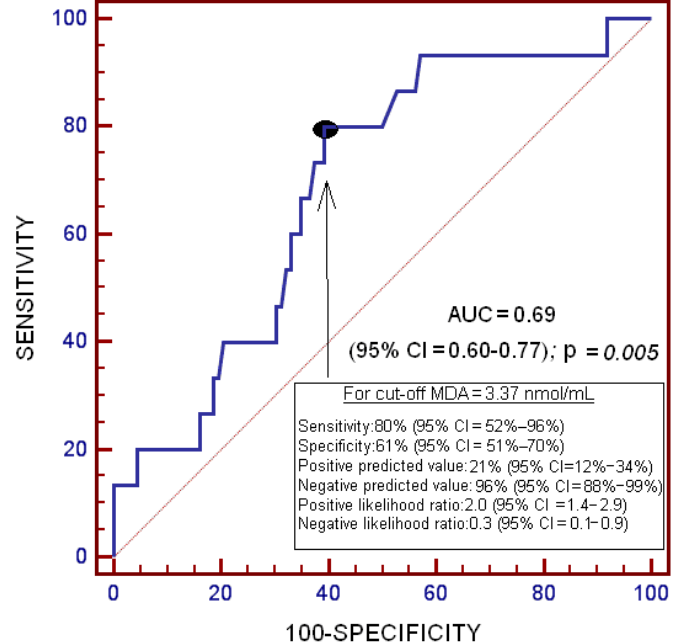
Figure 2. Receiver operator characteristic analysis using serum MDA levels as a predictor of death at 1 year after liver transplantation for hepatocellular carcinoma.